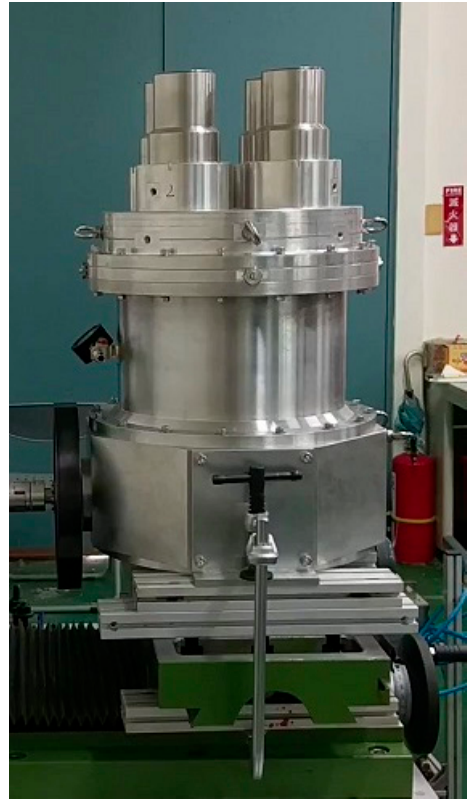
Figure 2. Prototype engine, DASE1, developed by Power Engine and Clean Energy Lab., NCKU.